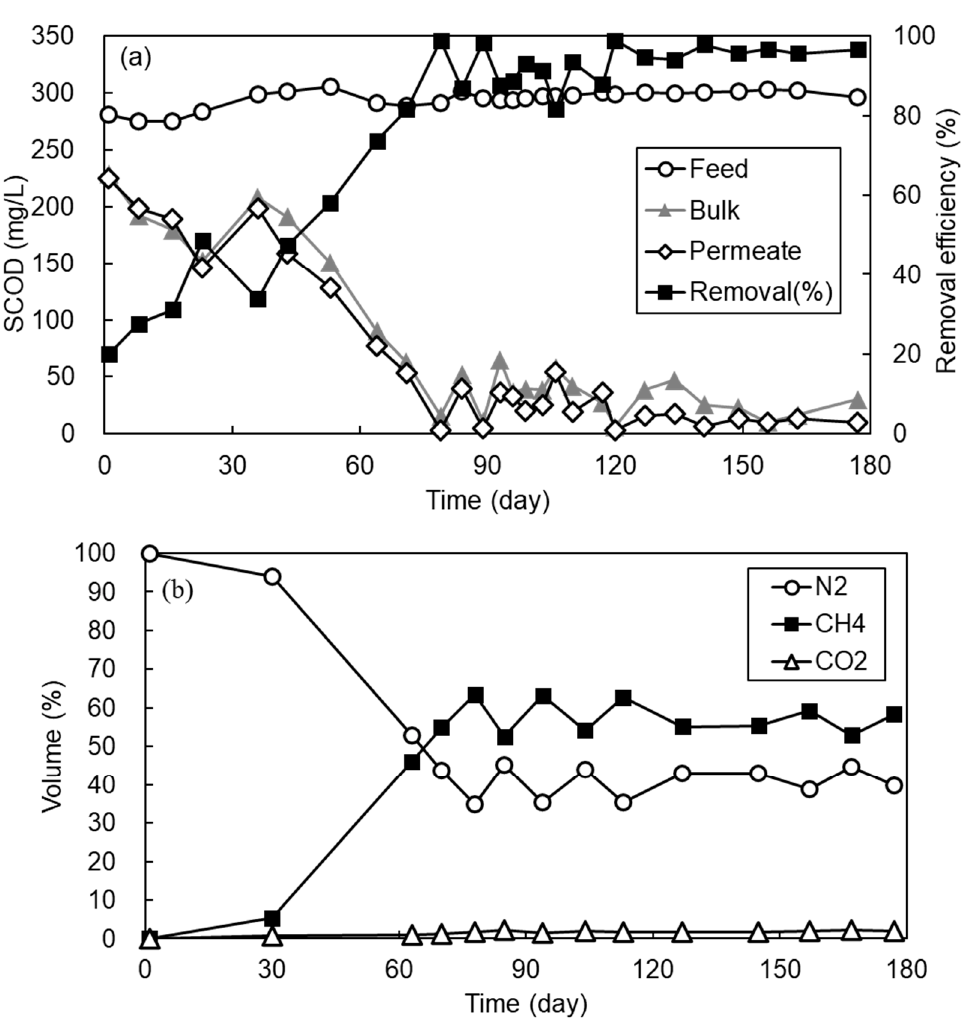
Figure 3. The variation of ( a ) SCOD and ( b ) biogas proportion for 180 days of AFMBR operation. Table 3. The mean value of AFMBR performance during each operational period.